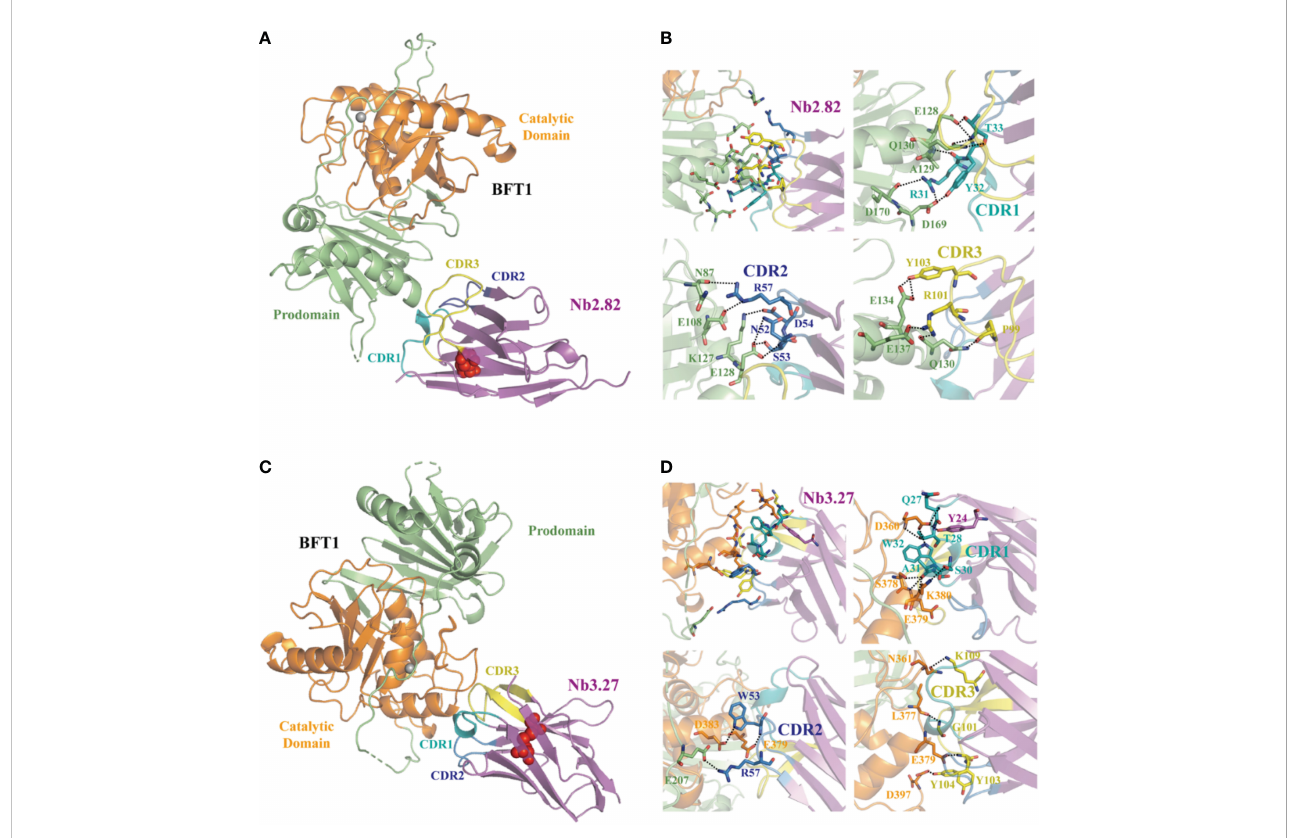
FIGURE 5 The structures of nanobodies in complex with BFT1. The overall crystal structures of nanobodies Nb2.82 and Nb3.27 in complex with BFT1 are shown in (A, C) respectively. The nanobodies are colored magenta, BFT1 prodomain is colored in lime, BFT1 catalytic domain is colored in orange. The CDR1, CDR2, CDR3 are shown in the color teal, skyblue and yellow, the cysteine involved in disul fi de bonding forming are denoted in red sphere. The magni fi ed views of the interaction region are shown in (B, D) respectively. The color mode is the same as in (A, C) , residues involving in interaction are shown as